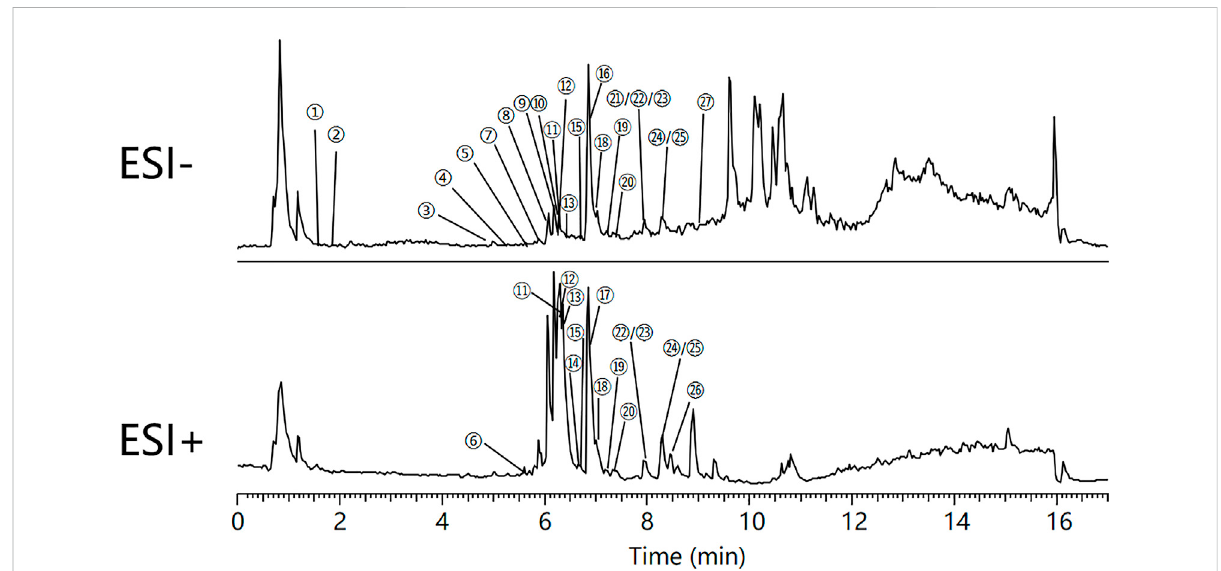
FIGURE 1 Total ion chromatograms of Qing-Re-Xiao-Zheng-Yi-Qi formula, in negative mode (ESI-) and in positive mode (ESI+). ① Geniposidic acid, ② Protocatechuic acid-4-glucoside, ③ Geniposide, ④ Pinoresinol diglucoside, ⑤ Quercetin 3,4 ′ -diglucoside, ⑥ Calycosin 7-O-glucopyranoside, ⑦ Kaempferol-3-O-rutinoside, ⑧ Glycitein, ⑨ Liriodendrin, ⑩ Matairesinoside, ⑪ Matairesinol, ⑫ Lappaol H, ⑬ 8-hydroxypinoresinol, ⑭ Ononin, ⑮ Arctiin, ⑯ Isoquercitrin, ⑰ Isochlorogenic acid A/B/C, ⑱ Lappaol C, ⑲ Calycosin, ⑳ Lappaol D, ㉑ Hyperoside, ㉒ Lappaol A, ㉓ Lappaol F, ㉔ Formononetin, ㉕ Arctigenin, ㉖ Lappaol B, ㉗